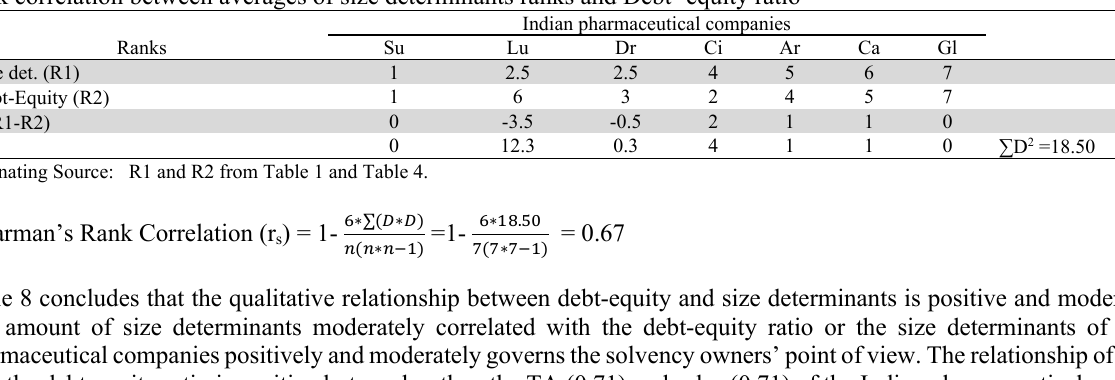
Indian pharmaceutical companies Su